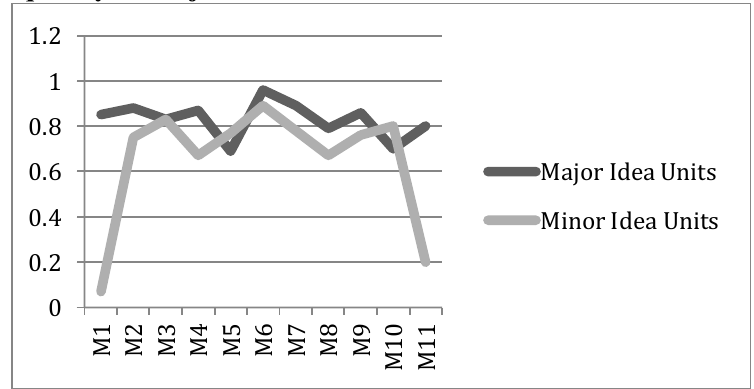
Frequency of major and minor idea units over time for Michelle